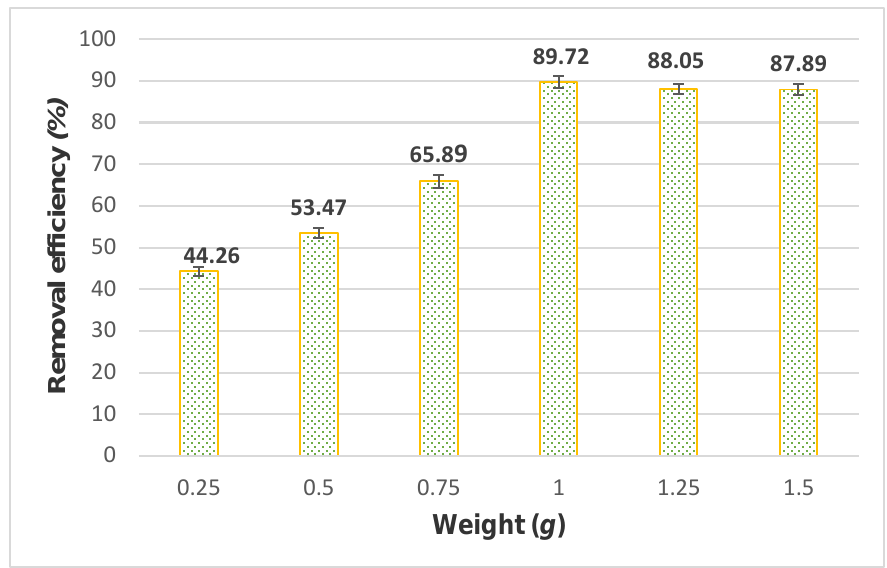
Figure 8. The effect of material dosage on phenol removal performance of Fe-Cu material.